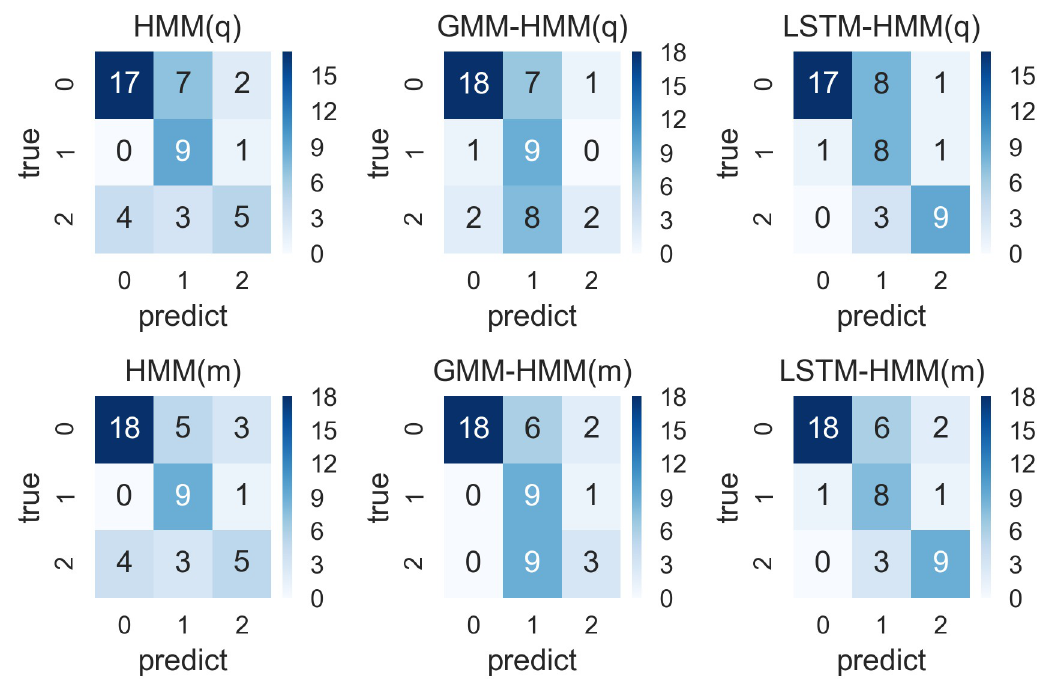
Fig 10. Confusion matrixes for prediction results from HMM, GMM-HMM and LSTM-HMM with monthly or quarterly input and 8-year time window.